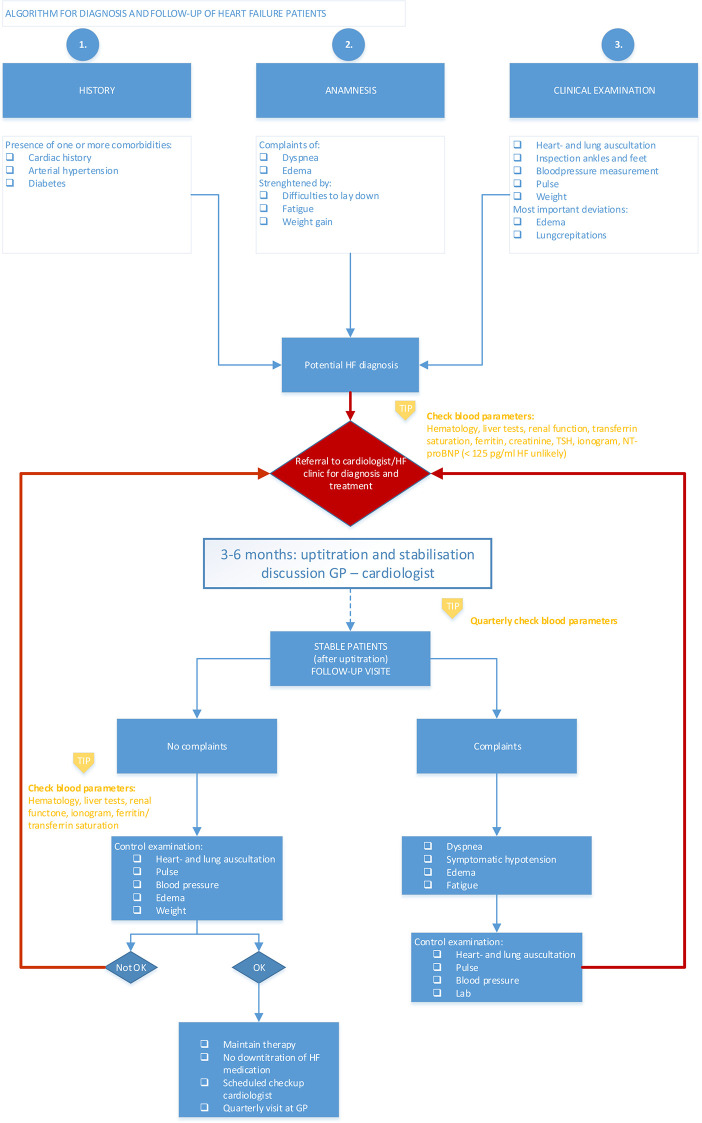
Algorithm for diagnosis and follow-up of HF patients.